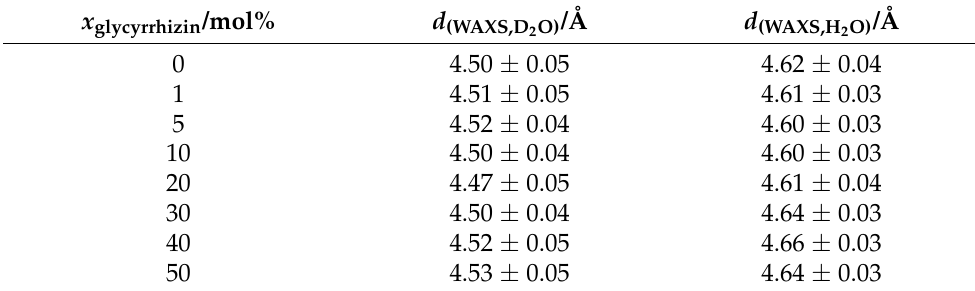
Figure 3. WAXS signal of mixtures of DOPG and glycyrrhizin in ( a ) D 2 O and ( b ) H 2 O buffer. The glycyrrhizin content is represented by the numbers on the right. For better readability, the data are baseline shifted by the gray values on the left. Red lines are Lorentzian fits. Dotted lines indicate the position of q WAXS in the absence of glycyrrhizin. Table 1. Chain–chain correlation distances d WAXS in vesicles composed of DOPG and glycyrrhizin with varying content obtained from the maximum of Lorentzian fits to WAXS data (see Figure 3) in D 2 O as well as H 2 O buffer. Within the experiment, no changes in d WAXS were observed upon addition of